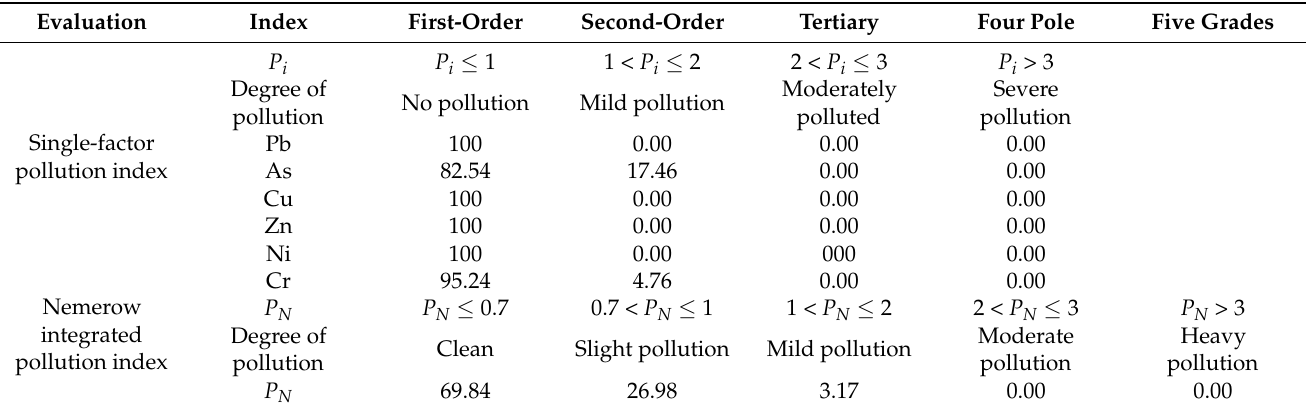
(Table 2). The soil heavy metals (Pb, As, Cu, Zn, Ni, and Cr) had various degrees of pollution in the study area. The single-factor pollution index of the soil area was less than 1 for the 6 heavy metals except for As and Cr. The single-factor pollution index of As and Cr indicated that 17.46% and 4.76% of the sample sites were classified as having Mild Pollution for As and Cr, respectively. Nemerow comprehensive pollution index showed that sites with Slight Pollution and Mild Pollution accounted for 26.98% and 3.17% of all the sampling sites, respectively, indicating that nearly 70% of the sampling sites in the study area had no heavy metal pollution in the soil. Table 2. Statistics of the proportion of soil heavy metal element pollution grade evaluation samples in the study